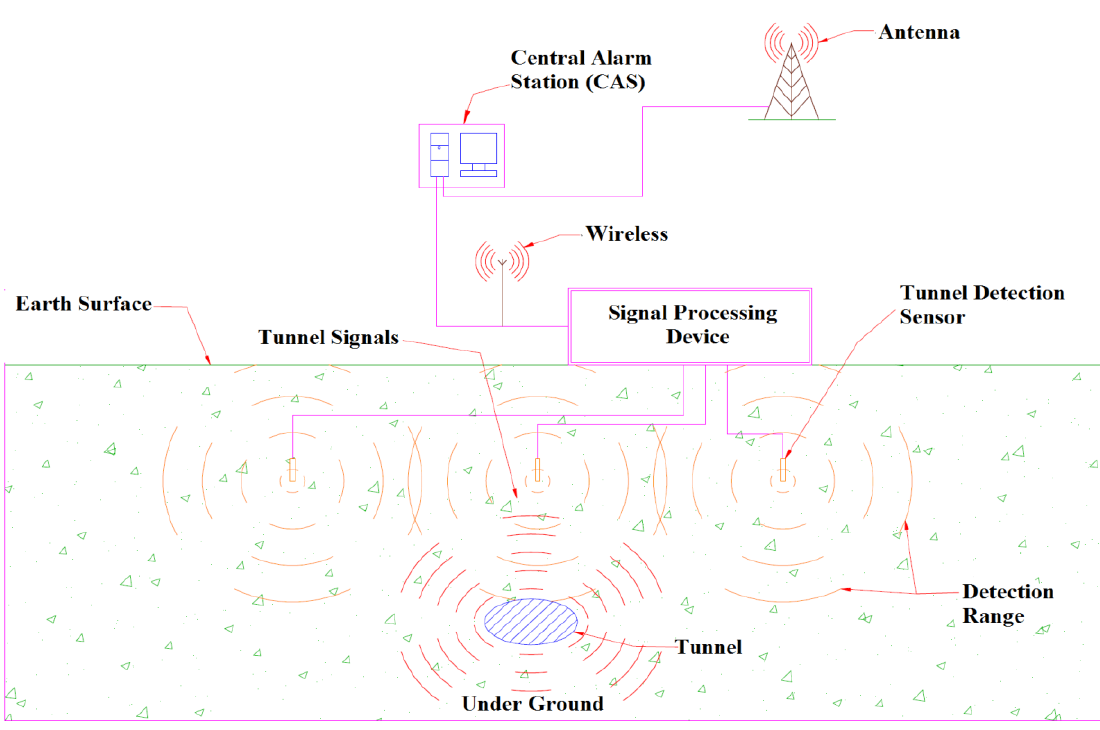
Figure 2.Overall layout of the tunnel threat detecting security system